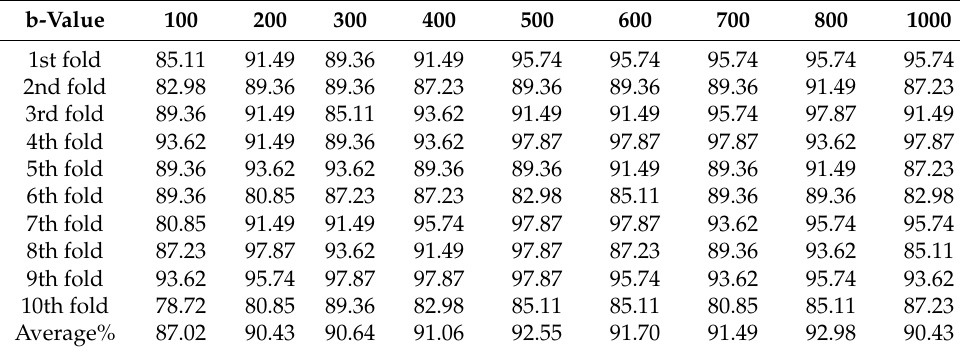
Table 8. 10-fold cross validation of VGGNet at 9